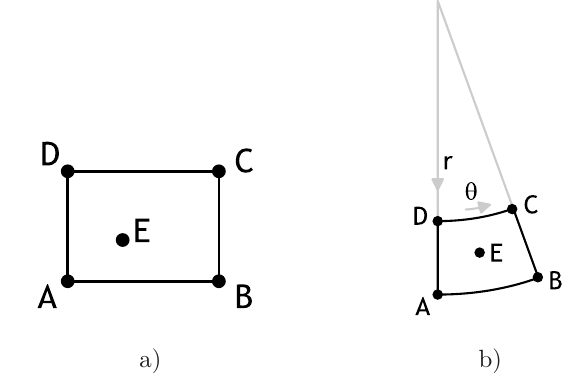
Figure 6. Interpolation: a) on Cartesian, b) polar coordinate